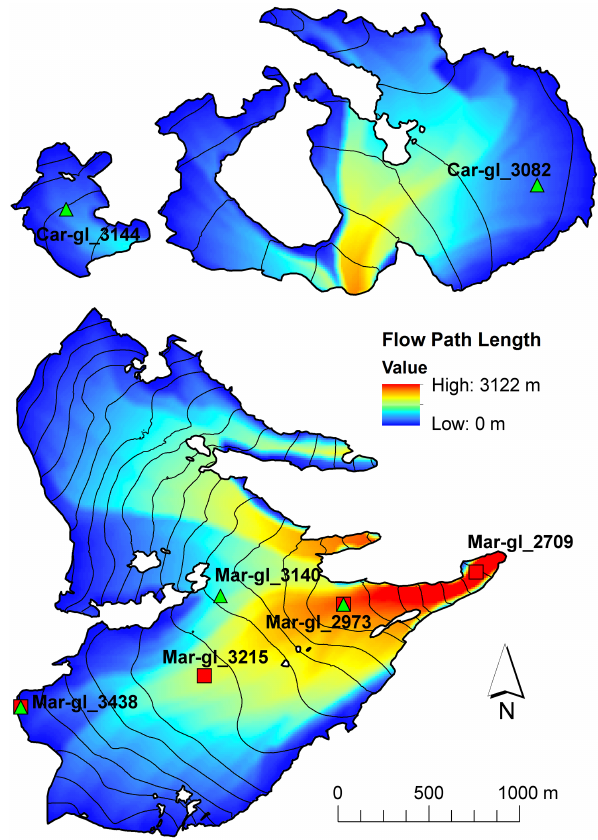
Figure 2. Map of the flow path length calculated for Careser and La Mare